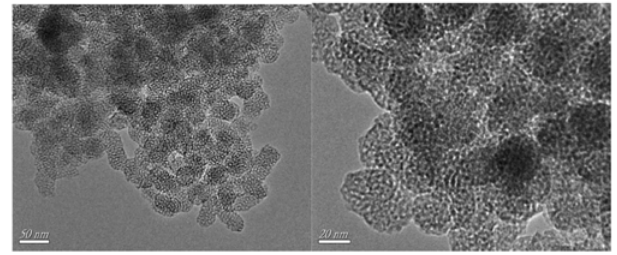
Figure 10. TEM images of the W ‐ SiO 2 ‐ 20 catalyst. Reproduced with permission [129]. Copyright 2016, Elsevier.